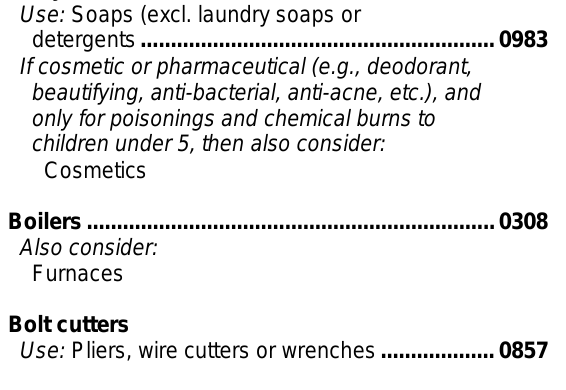
requiring special boots, use code for that